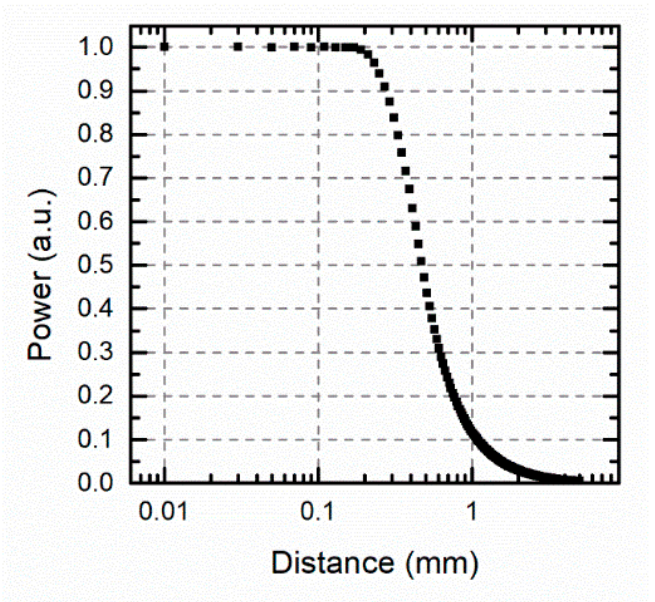
Figure 6. The proposed model simulations with new integration limits. Power measured by the pyrometer for different distances to the target at 2000 ◦ C and using the parameters shown in Table pyrometer for different distances to the target at 2000 °C and using the parameters shown in Table 2.